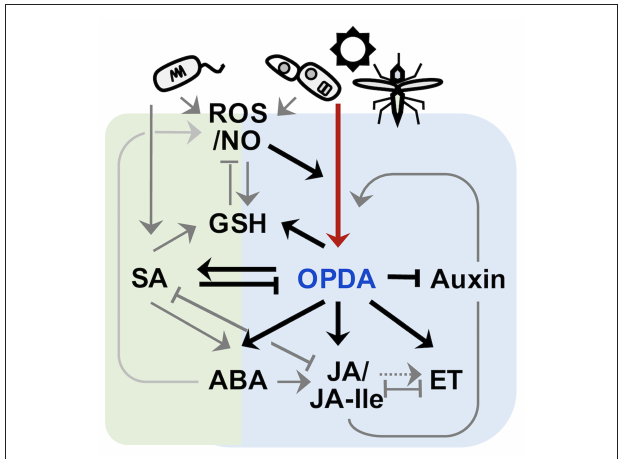
FIGURE 1 | Schematic crosstalk of OPDA with the signaling pathways of other phytohormones. OPDA and JA/JA-Ile (collectively, jasmonate) signaling activates defense responses to various forms of biotic and abiotic stresses, including necrotroph infection, insect attack, wounding, and UV damage, whereas salicylic acid (SA) signaling confers disease resistance against mostly biotrophic pathogens. Once recognized “non-self,” plants rapidly produce ROS including nitric oxide (NO) ( Huang et al., 2004; Wang et al., 2013), which in turn actuates jamonate biosynthesis (Palmieri et al., 2008). OPDA signaling then stimulates and coordinates with different defense signaling, e.g., JA/JA-Ile, SA, ABA, ethylene (ET), and GSH pathways (Taki et al., 2005;